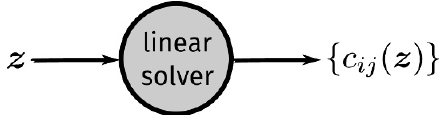
Figure 3 . A node representing a linear solver. It takes as input a list of parameters z and returns the coe(cid:14)cients of the solution de(cid:12)ned in eq. (4.5) and